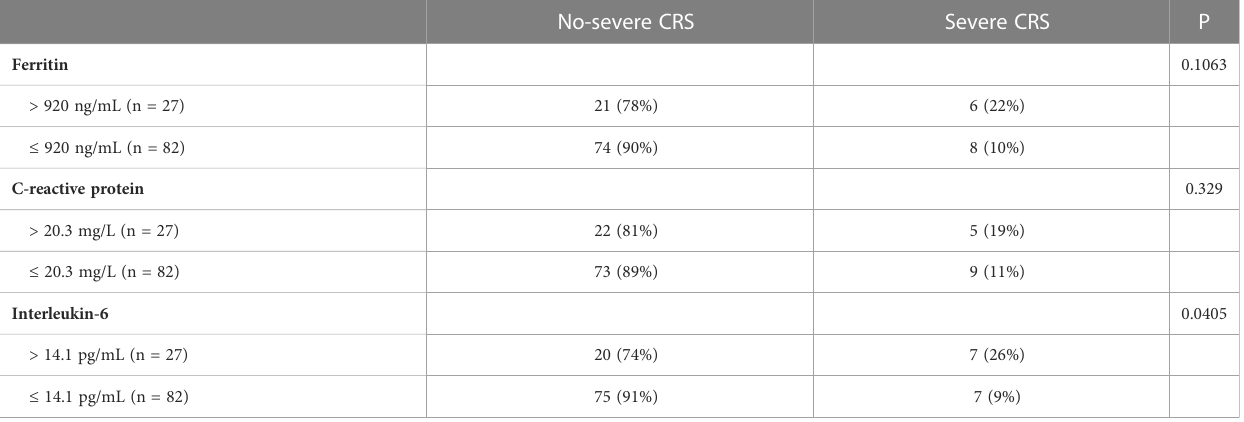
TABLE 3 Association between pre-infusion in fl ammatory markers and